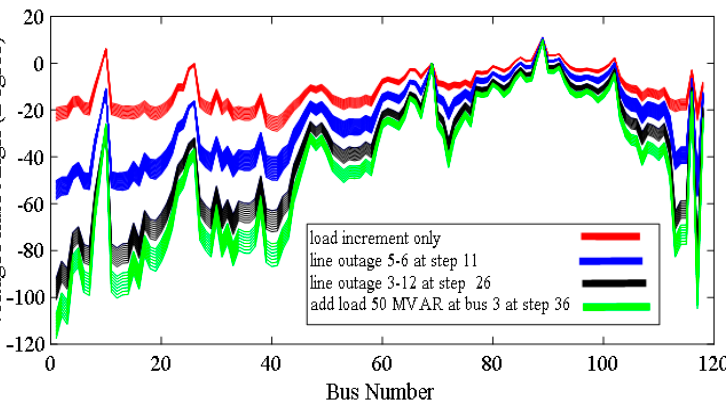
Figure 19. Phase angle of the voltage profile during the events leading to the voltage collapse point for the IEEE 118-bus test system.